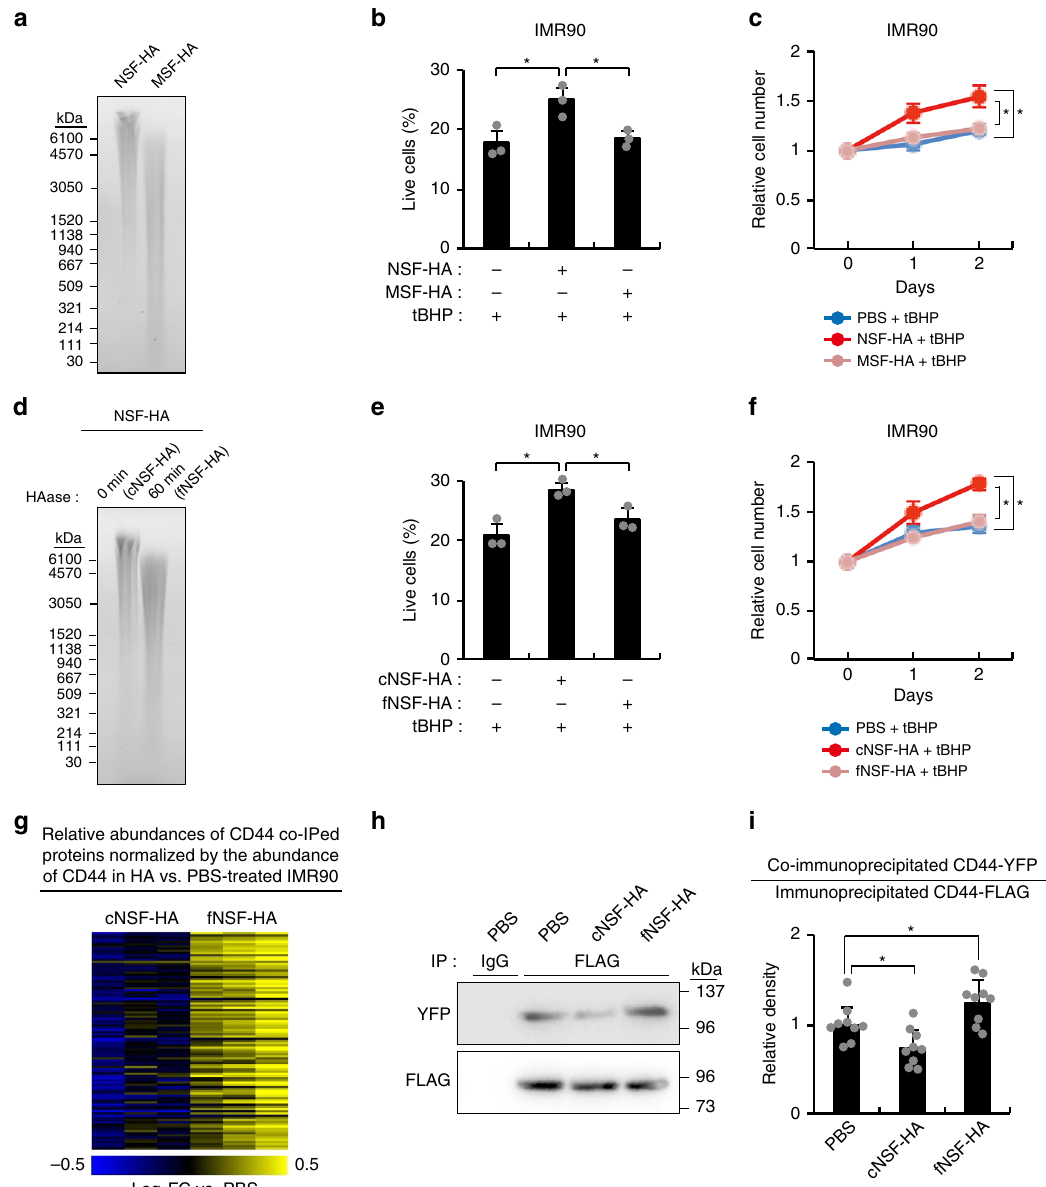
Fig. 2 vHMM-HA has superior cytoprotective properties. a Pulse- fi eld gel electrophoresis image of NSF-HA and MSF-HA. The experiment was repeated once with similar result. b NSF-HA, but not MSF-HA, suppresses oxidative stress-induced cell death in IMR90 cells. The percentages of live cells were measured by Annexin-V/PI staining 1 day after 1 h of 3 mM tBHP-treatment ( n = 3). Cells were pre-incubated for 6 h with 20 μ g/ml NSF-HA, MSF-HA, or PBS before tBHP-treatment. c NSF-HA, but not MSF-HA, suppresses oxidative stress-induced growth arrest in IMR90 cells ( n = 4). Cells were pre- incubated for 6 h with 20 μ g/ml of NSF-HA, MSF-HA, or PBS and then HA was removed and cells were exposed to 200 μ M tBHP for 1 h on day 0 and